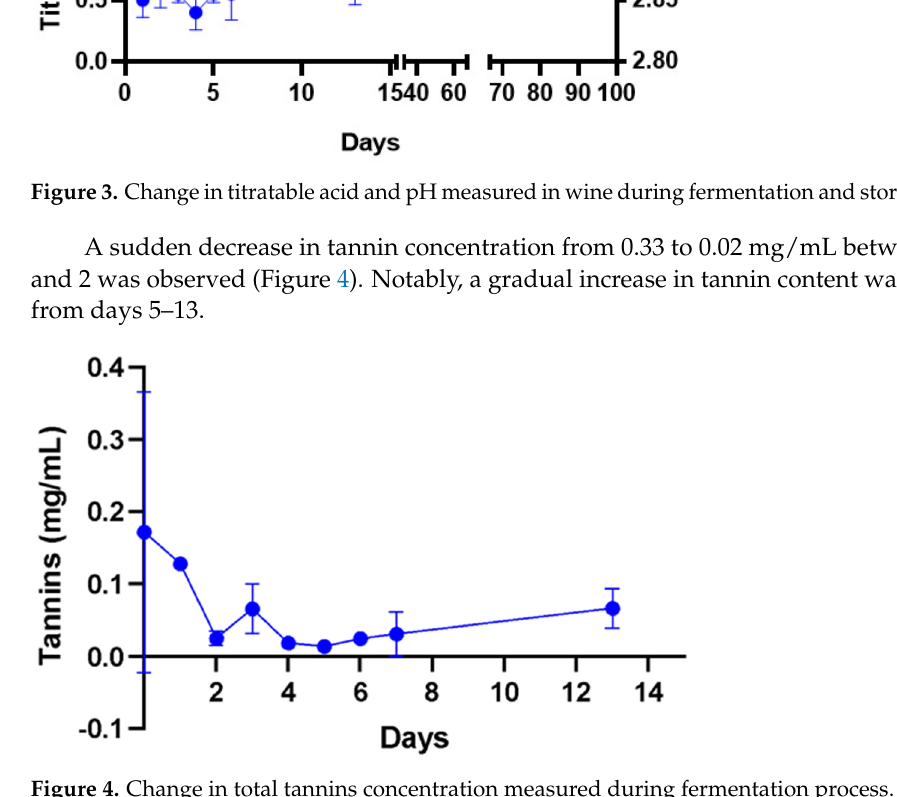
Figure 4. Change in total tannins concentration measured during fermentation process.